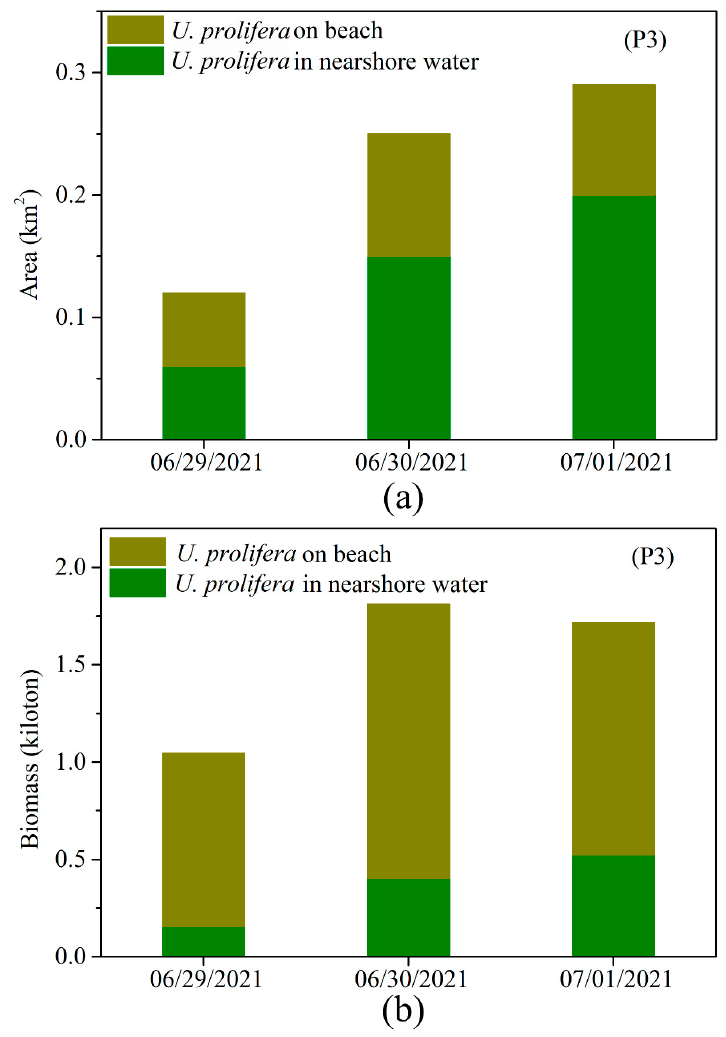
Figure 11. The statistical results for coverage area and biomass of U. prolifera in the P3 area. ( a ) The statistical results for the coverage area of U. prolifera on the beach and in nearshore water; ( b ) the statistical results for the biomass of U. prolifera on the beach and in nearshore water.